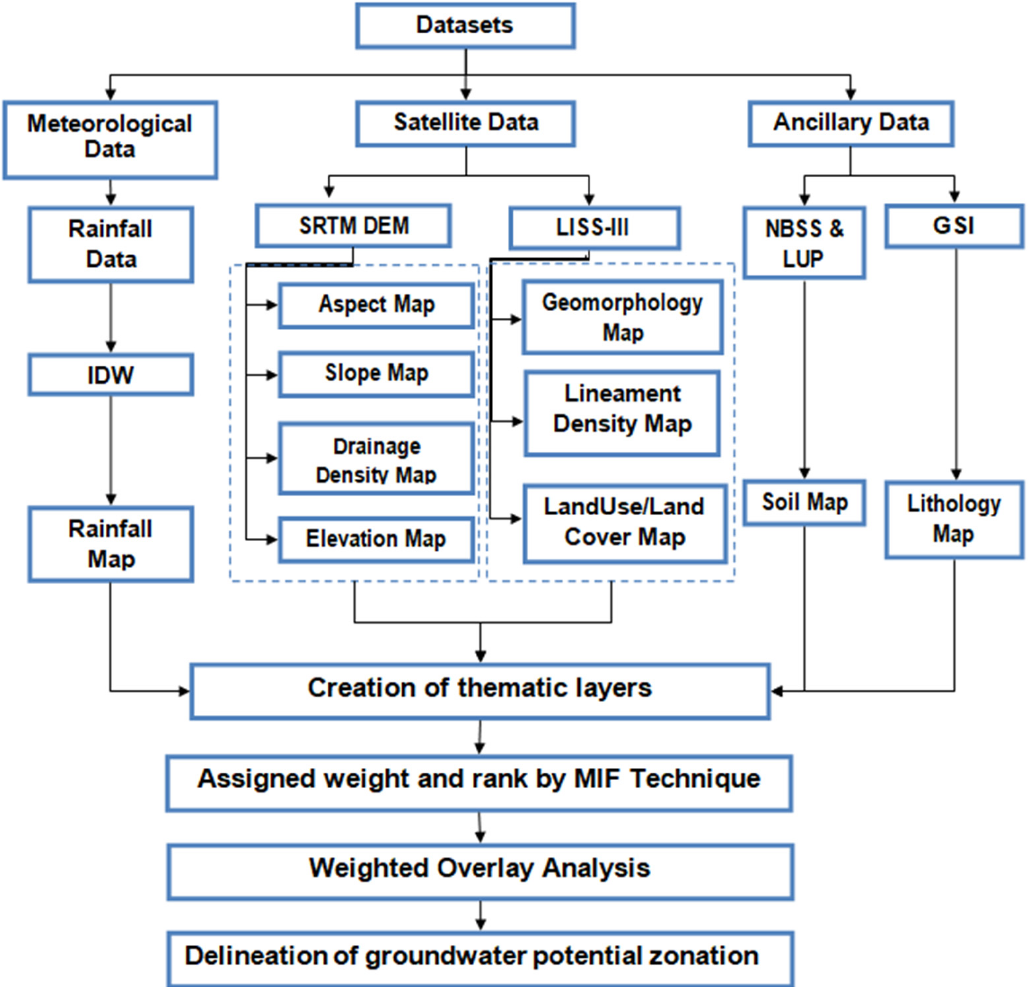
Figure 2. Methodology flowchart used in the study.